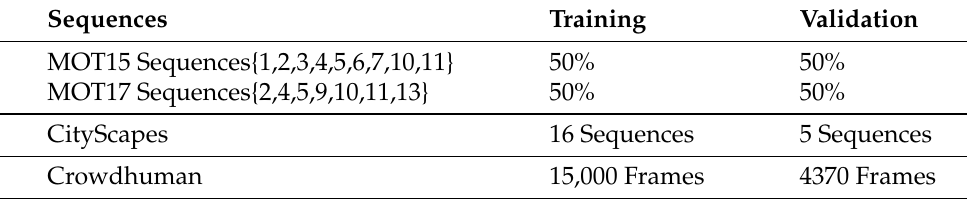
Table 1. Sequences mentioned in the table are used to train the deep neural network.